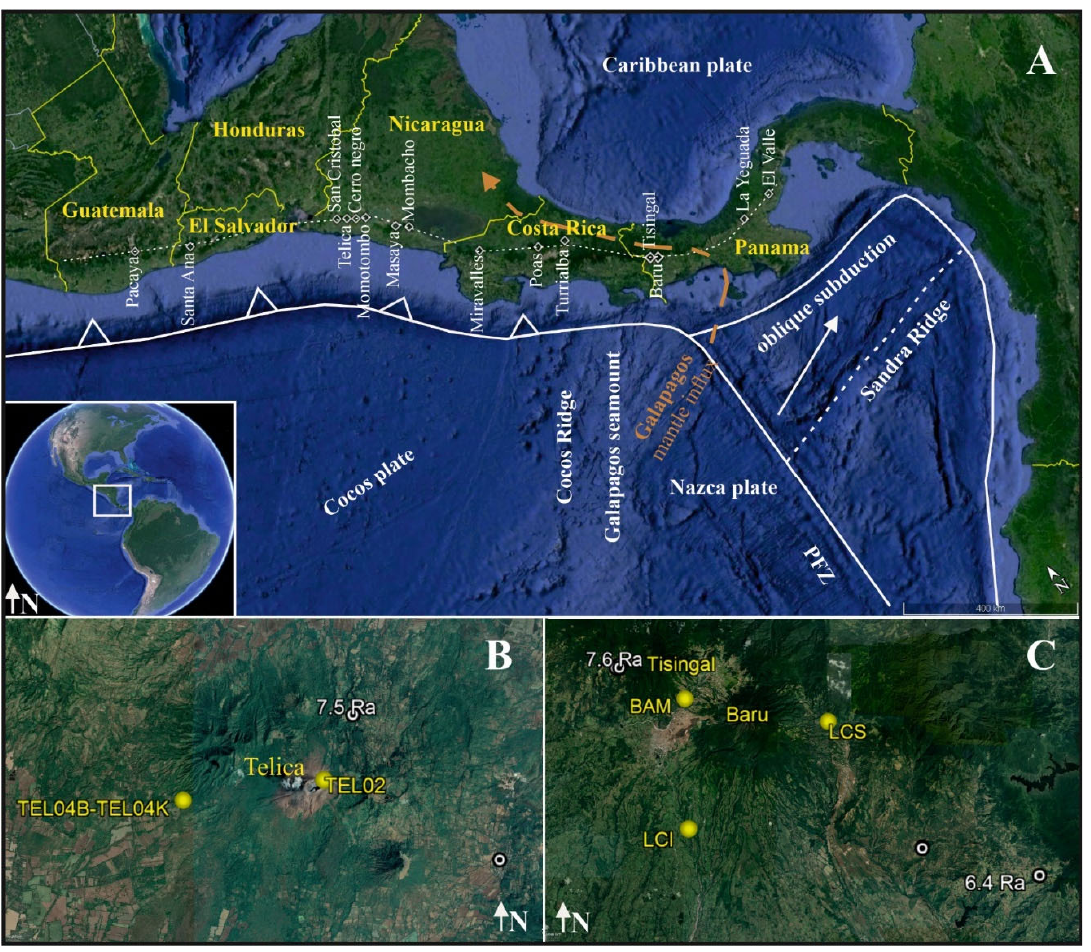
Figure 1. ( A ) Map of the geodynamics of the Central American Volcanic Arc (CAVA), indicating arc ‐ segments from Guatemala to Panama. The white line with the transparent arrows indicates the subduction front direction, while its prolongation to the East indicates the oblique subduction beneath Panama and to the south ‐ east, the Panama fracture Zone (PFZ). The orange dotted line indicates the Galapagos mantle influx inferred by [61]. The white dotted line reports the main location of the volcanic arc front from Guatemala to Panama. The volcanoes mentioned in the text are also reported. ( B ) Inset of map A on Telica volcano (Nicaragua), where our sample location (in yellow) is reported together with the spring gases (in white) studied by [42] with the maximum air-corrected 3 He/ 4 He (Rc/Ra). ( C ) Inset of map A on Baru volcano (Panama), where our sample location (in yellow) is reported together with the neighboring spring gases (in white) studied by [61] with the maximum air-corrected 3 He/ 4 He (Rc/Ra). The sampling sites abbreviation is explicated in Table